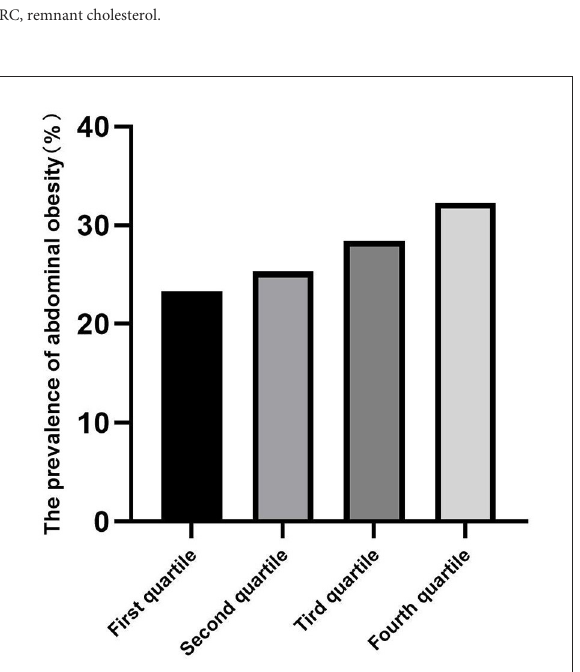
FIGURE2 The prevalence of abdominal obesity among remnant cholesterol (RC) quartiles in total participants.